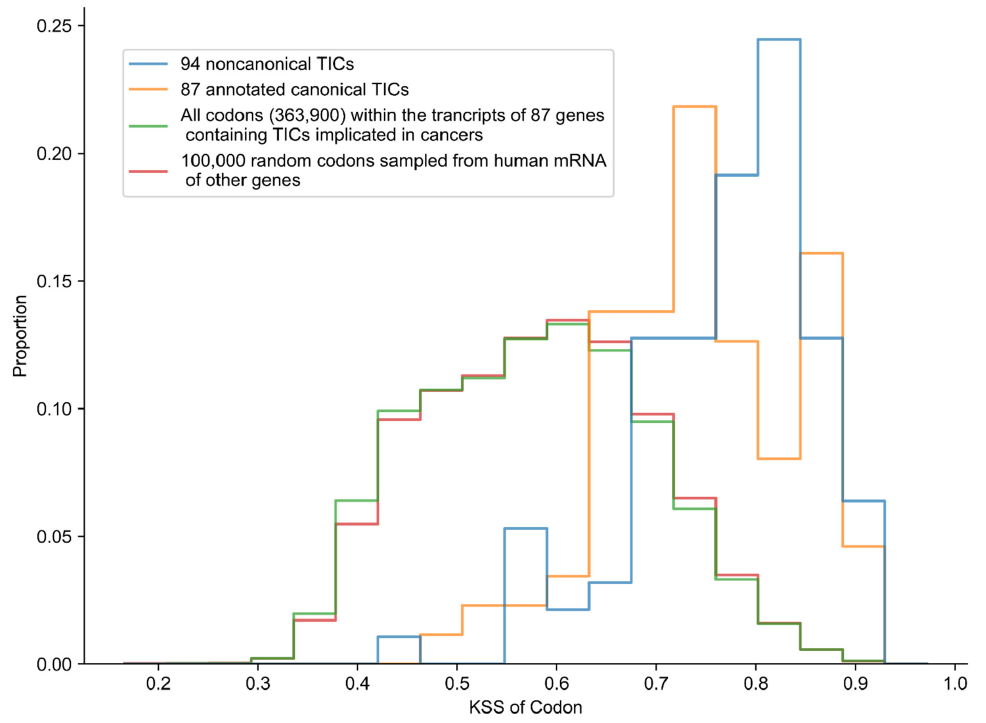
Figure 2. KSS distribution of